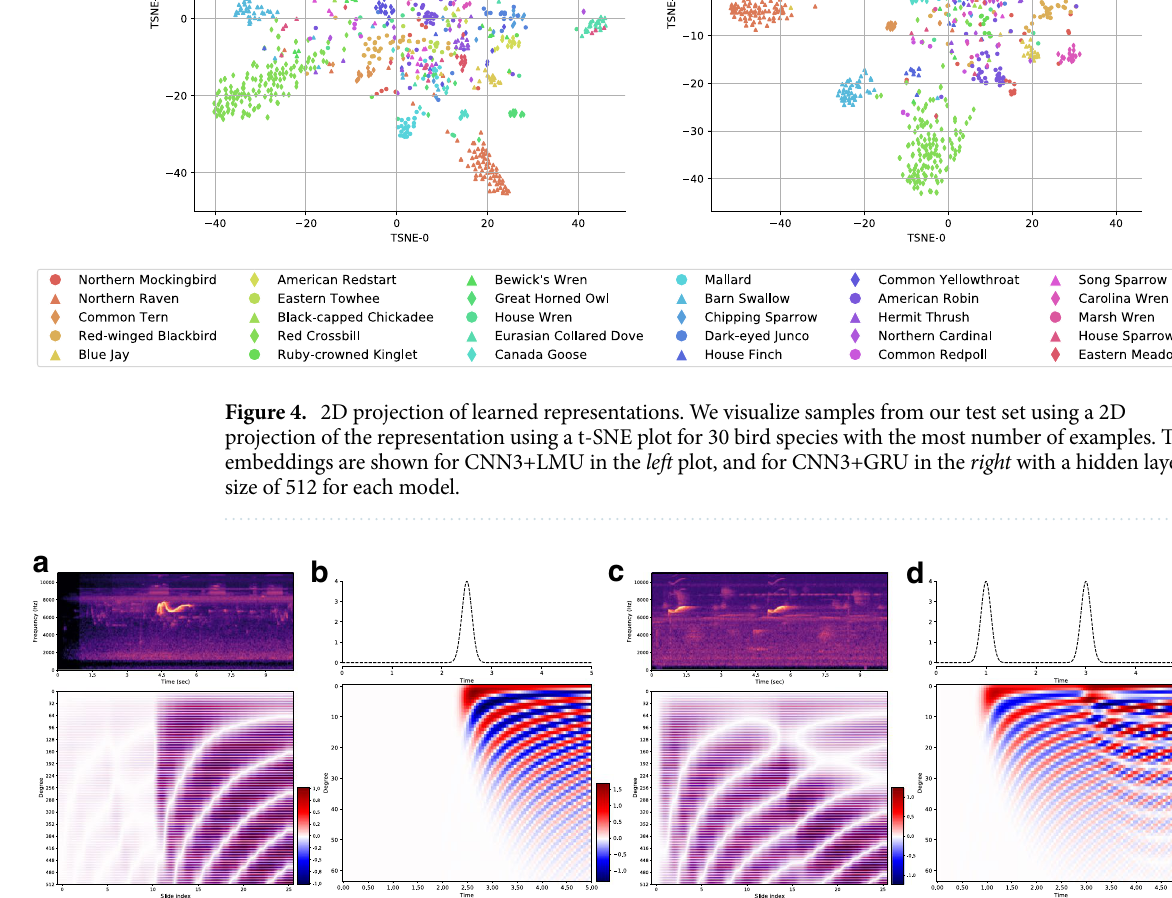
Figure 5. LMU memory channels. LMU memory channels behavior vs time for input signals in the form of pulse. For each subplot, the input is shown in the top and the bottom is memory channels value vs time. A bird sound test sample with single/double spectrogram pulse is shown in ( a , c ), respectively. The time in spectrogram is synchronized with the slide index in accordance with the chosen values of ( W s , H s ) (see “Methods”). Simulated version of single/double pulse input is shown in ( b , d ),